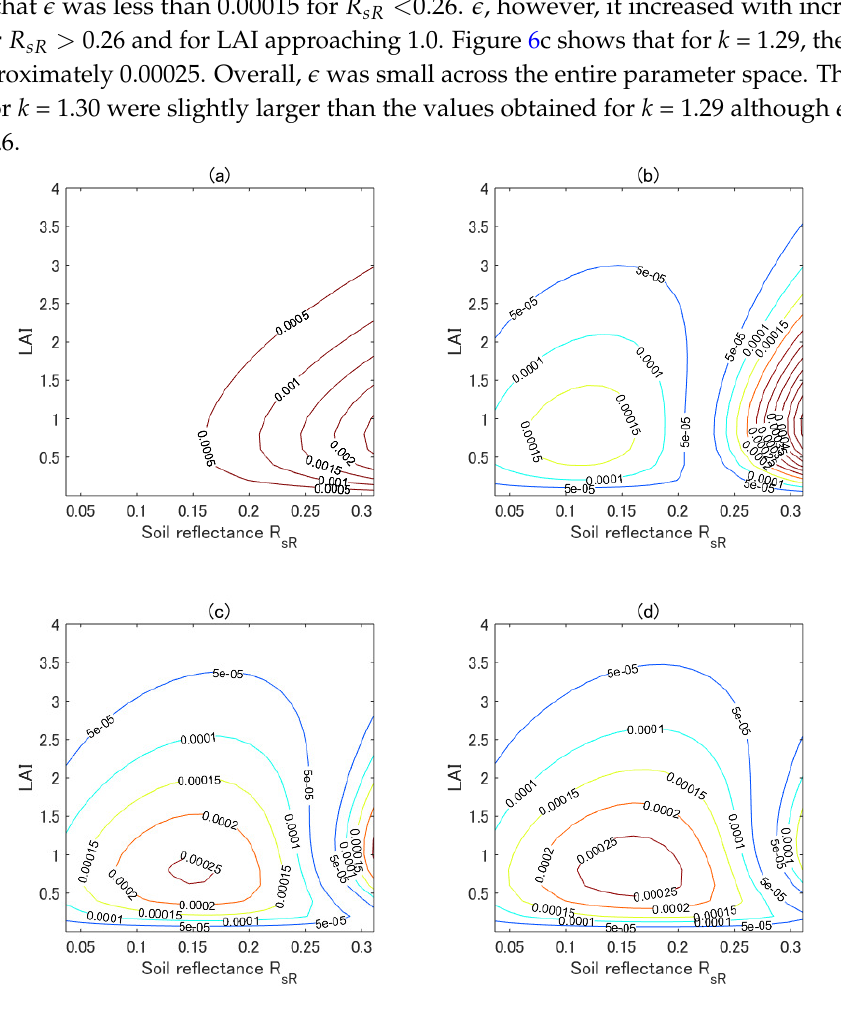
Figure 6. ( a ) Contour plot of (cid:101) over LAI and R sR space for k = 1.00; ( b ) Contour plot of (cid:101) for k = 1.25; ( c ) Contour plot of (cid:101) for k = 1.29; ( d ) Contour plot of (cid:101) for k =